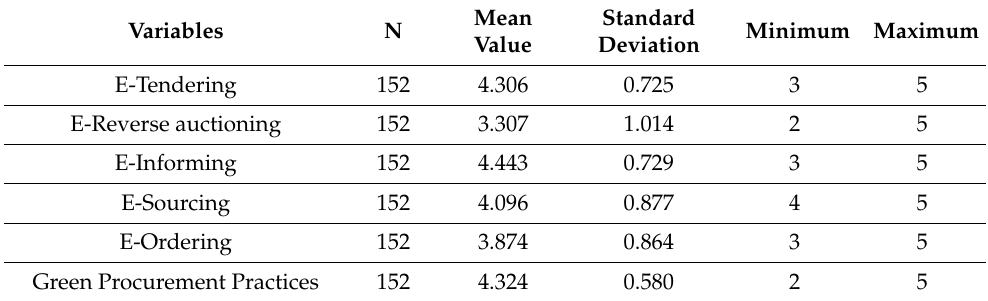
Table 3. Descriptive